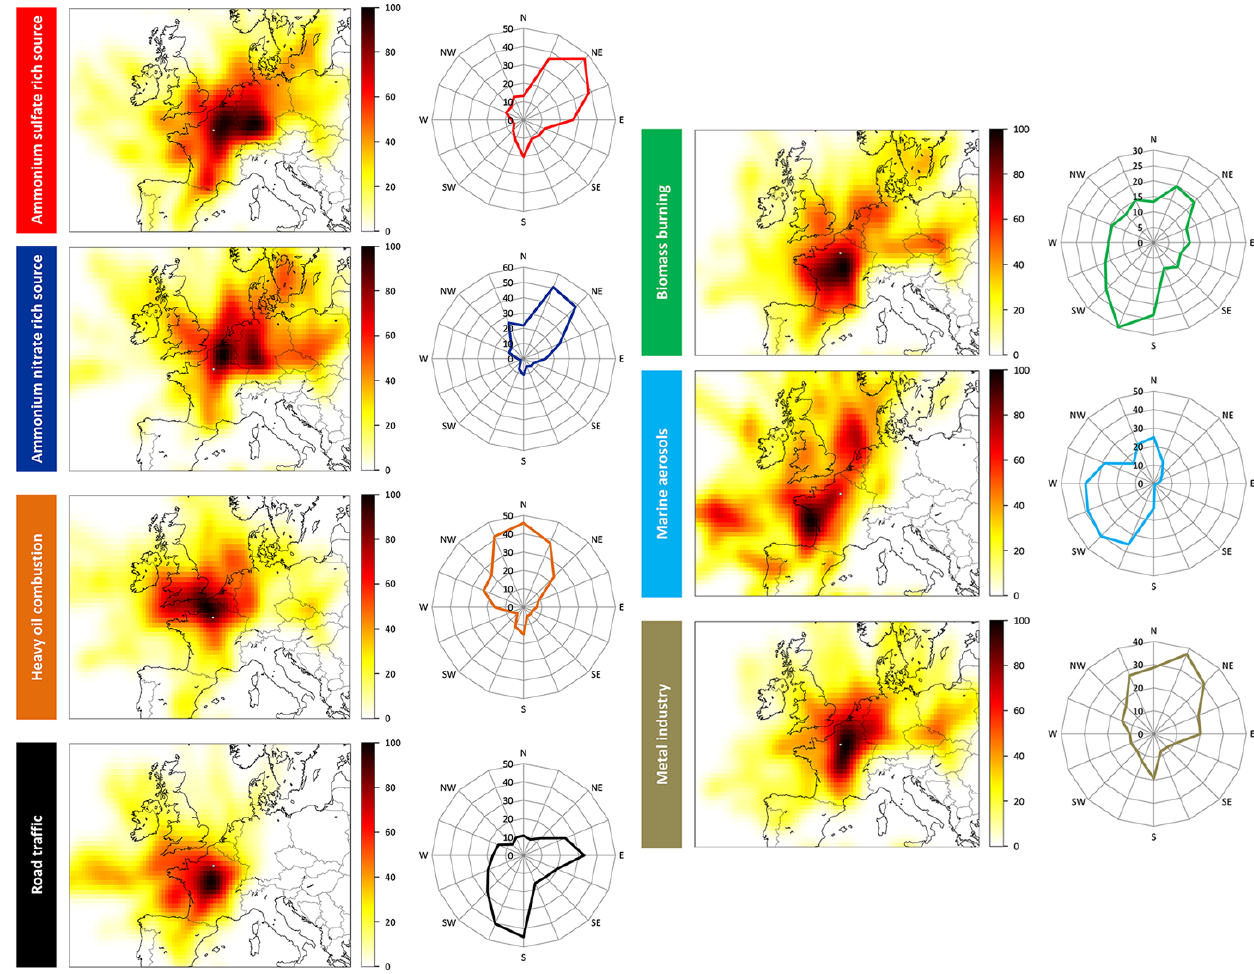
Figure 5. Probability (in %) that the contribution of a source exceeds the 75th percentile of all its contributions, when air masses came from a given air parcel (left, PSCF), or a given wind direction (right, CPF). Note that the city of Paris is indicated by a grey dot on PSCF figures; for each source, PSCF probabilities have been normalized to